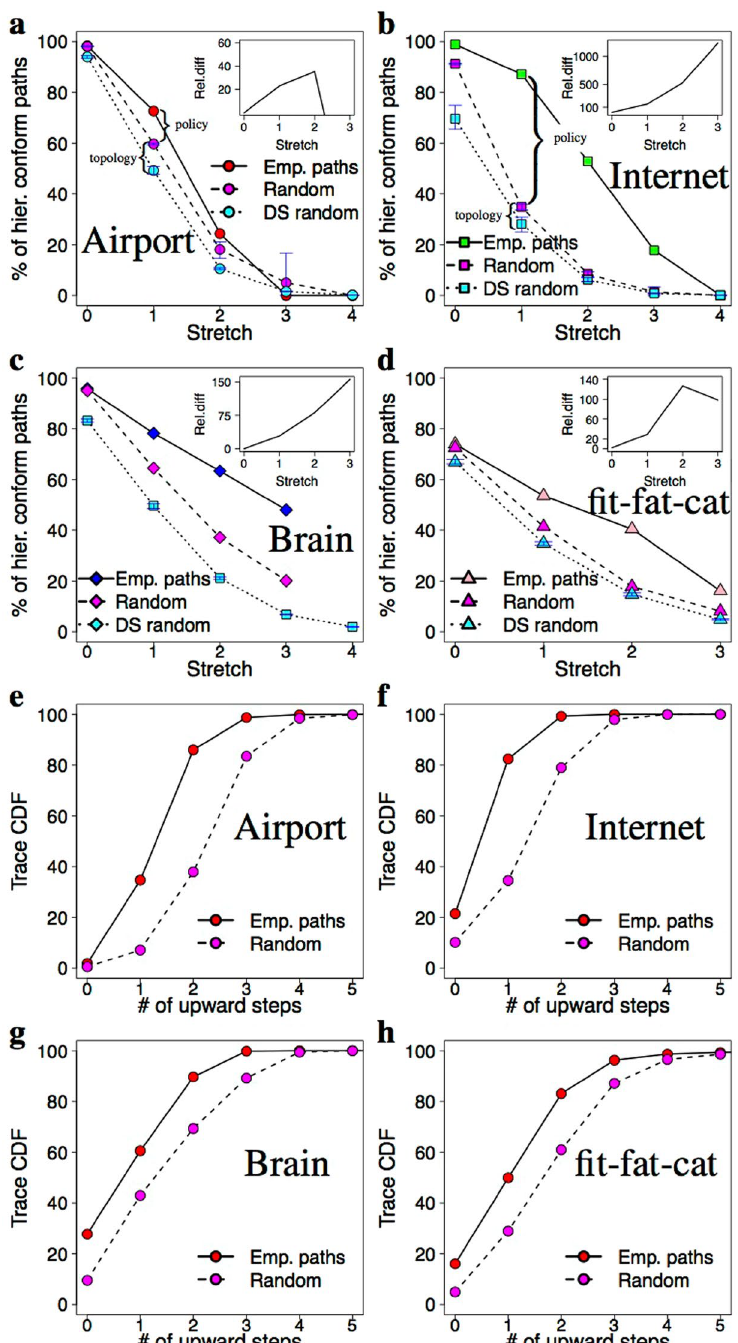
Figure 3. Identified routing policies confirmed by our measurement data. Panels (a–d) show the hierarchical conformity of the empirically-determined paths against stretch. The inset of the plots shows the relative difference between the number of CH paths in the empirical and the random paths. In the case of small networks there are 15–85% more CH paths in the empirical traces but in the case of the large AS level Internet this goes up to 100–500%. The cyan colored data in the plots show the number of CH paths in a randomized version of our networks generated with the degree sequence (DS) algorithm which produces exactly the same degrees for the nodes but the edges are completely randomized. The plots confirm that the topological peculiarities of real networks increase the number of CH paths between endpoints with respect to the DS networks (see the explanation brackets between the cyan and magenta colored dots of panel (a,b)). However, we argue that the effect of the CH policy is at least that important or even more fundamental (e.g. in case of the Internet). Panels (e–h) show the cumulative distribution of upstream steps in the traces of our datasets. The empirical paths tend to avoid stepping towards the core, which is reflected by the much lower number of upstream steps (in comparison with the randomly selected CH paths of the same length) before entering the downstream